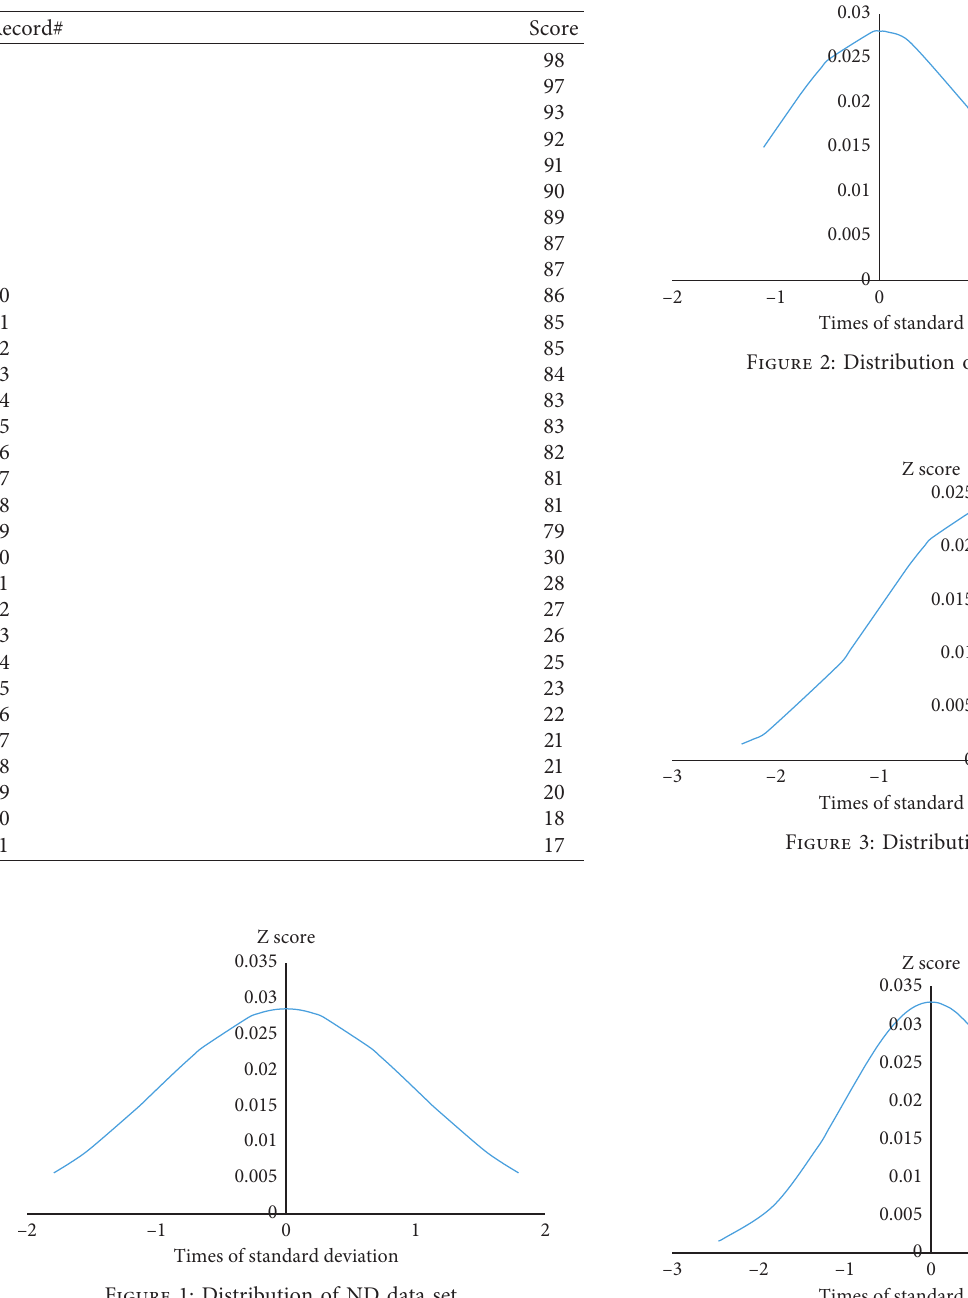
Table 6: Sorted scores of WD data set.